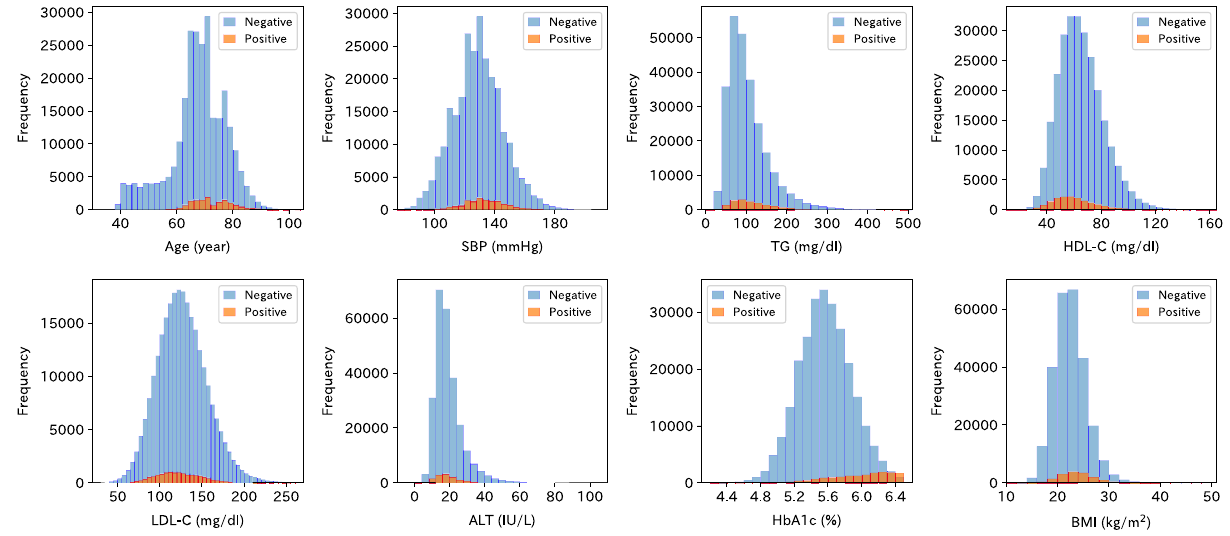
Figure 1. Distributions of all the continuous variables. The histograms of the negative group are denoted by a blue color, whereas those of the positive group are denoted by an orange color. The distributions are truncated at 100 for ALT and 500 for TG for better presentation.